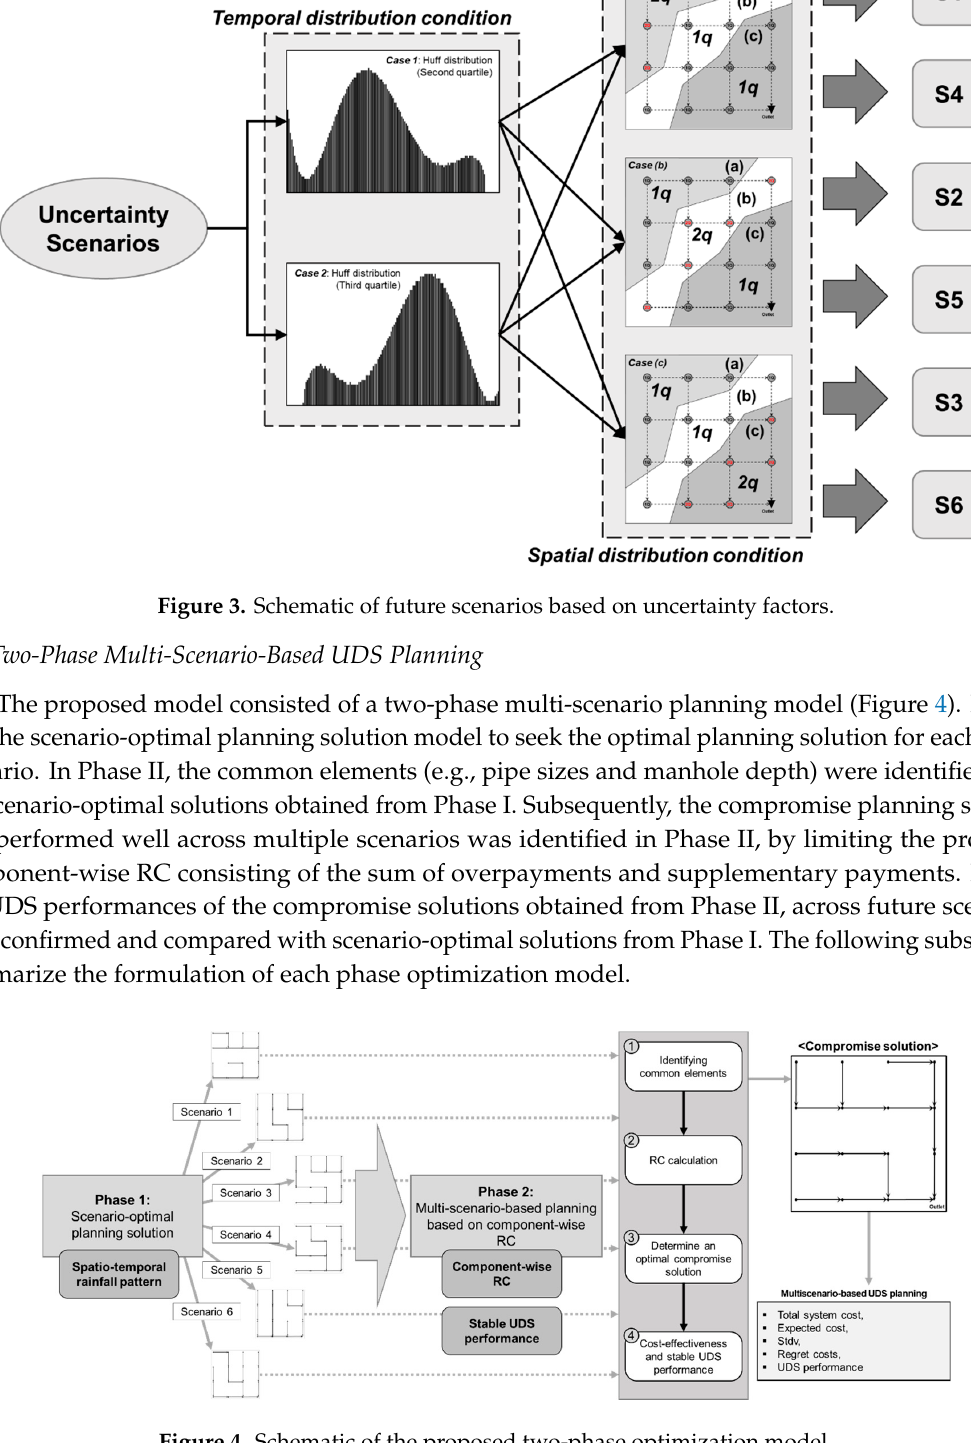
Figure 4. Schematic of the proposed two-phase optimization model .